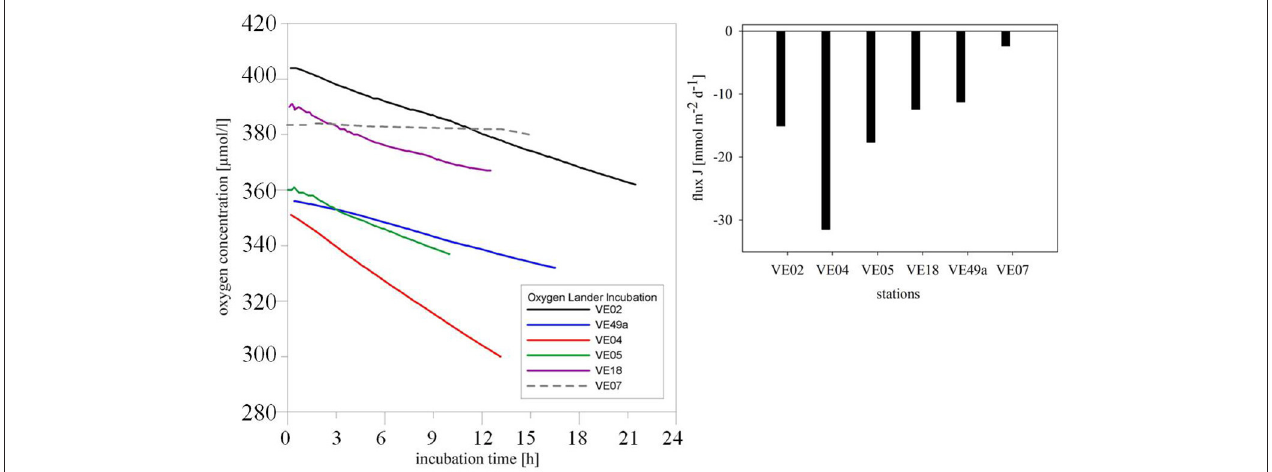
FIGURE 4 | Change in the oxygen concentrations in the chamber over time. Solid lines in black (VE02), blue (VE49a), red (VE04), green (VE05), and violet (VE18) indicate the coastal stations, and the dashed gray line the intermediate station VE07 (left) . Oxygen consumption at the different stations is expressed as the flux (mmol m − 2 d − 1 ) (right)